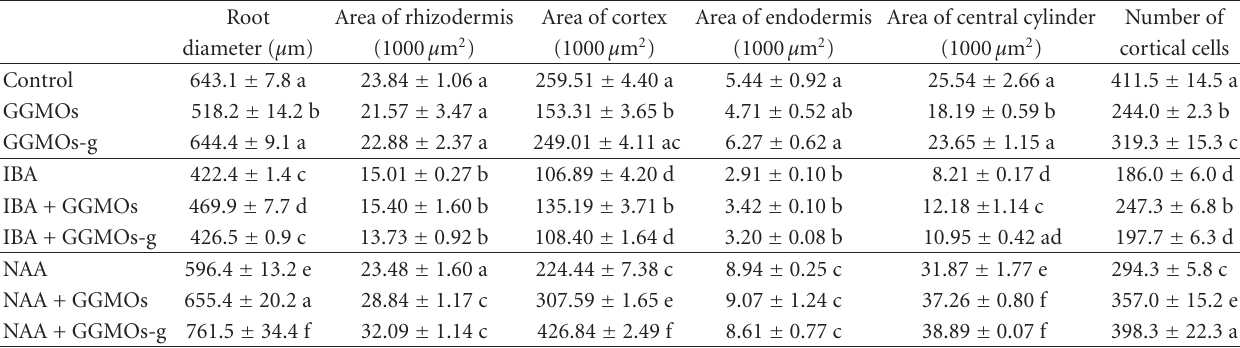
Table 2: E ff ect of GGMOs, GGMOs-g alone, or in combination with IBA or NAA on the root diameter, area of rhizodermis, cortex, endodermis, central cylinder, and number of cortical cells of mung bean adventitious roots. Particular tissues were measured on transversal root sections. Means in each column followed by the same letters are not significantly di ff erent at P < 0 . 05 according to LSD